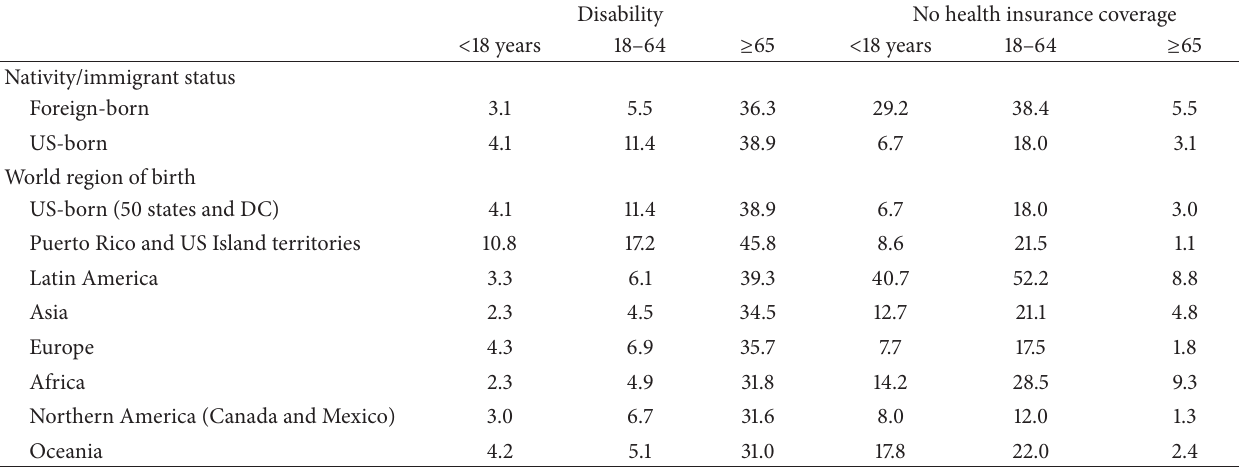
Table 8: Rates (weighted%) of disability and no health insurance coverage among US children, working-age adults, and elderly according